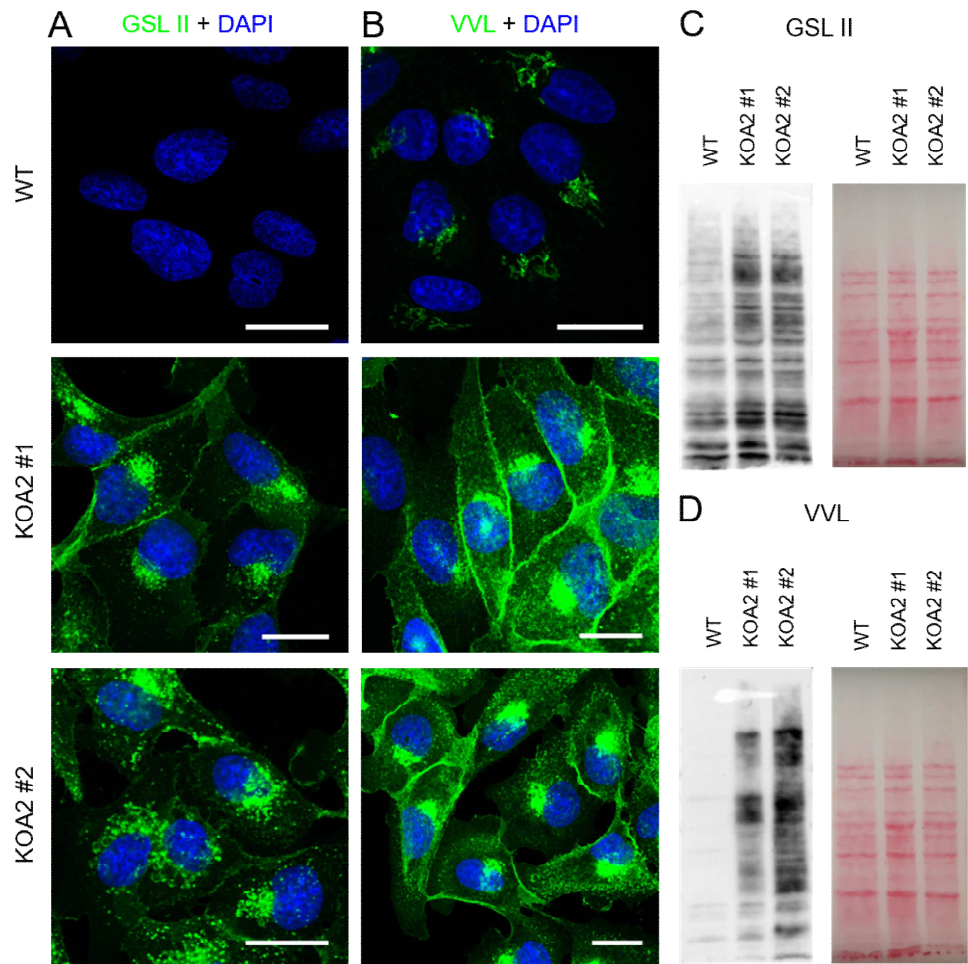
Figure 2. SLC35A2-deficient MDCK cells have impaired galactosylation. ( A , B ) Lectin stainings of cellular glycoconjugates using GSL II ( A ) and VVL ( B ). Lectin-stained glycoconjugates are shown in green and cell nuclei are shown in blue. Scale bar corresponds to 20 μm. ( C , D ) Lectin blotting analyses of cellular glycoproteins using GSL II ( C ) and VVL ( D ). Ponceau S stainings are presented alongside to demonstrate equal loading.